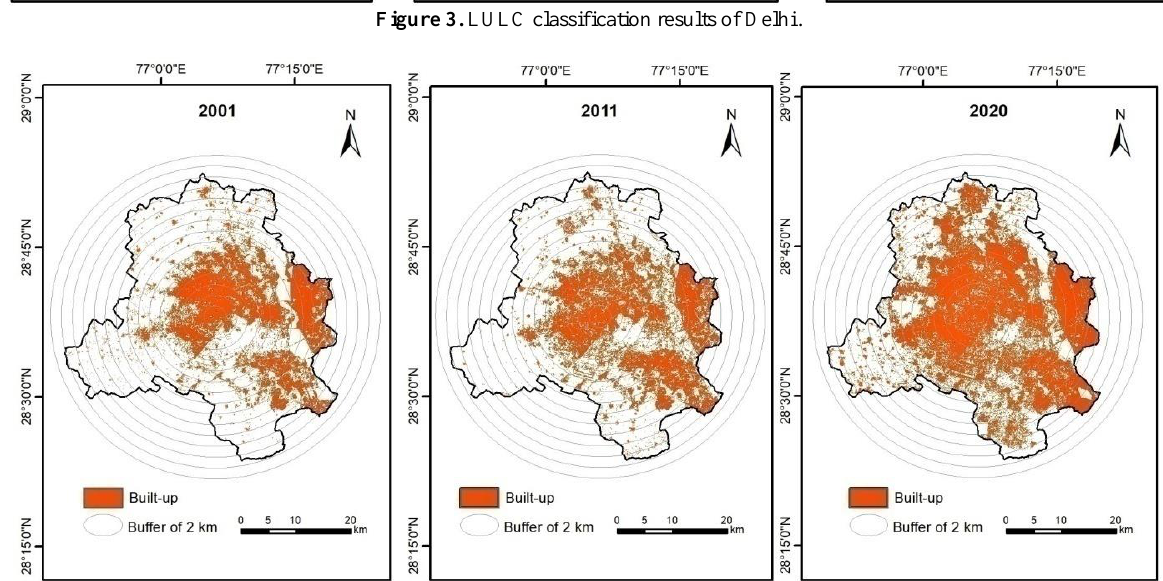
Figure 3. LULC classification results of Delhi.